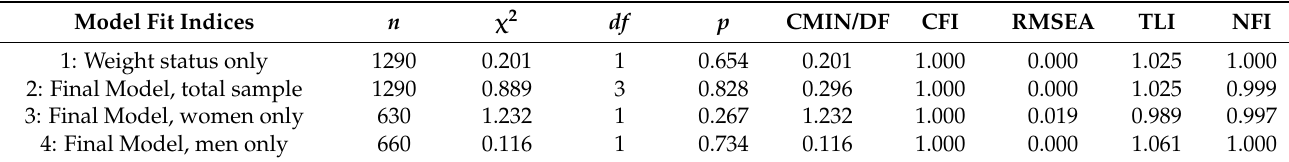
Figure 1. Models 1 to 4: Direct and indirect effects of weight status and workplace bullying on psychological health impairments while controlling for sociodemographic variables. Notes: Standardized regression weights are depicted. Only significant associations are depicted. Different significance levels are depicted with black lines ( p < 0.001) or gray lines ( p < 0.05). Burnout symptoms measured by Burnout Screening Scales II. Quality of life measured by Euro-Qol Quality of Life Index. SES = socioeconomic status. Table 2. Path analysis on the mediating effect of workplace bullying on associations between weight status and psychological health impairments: model fit